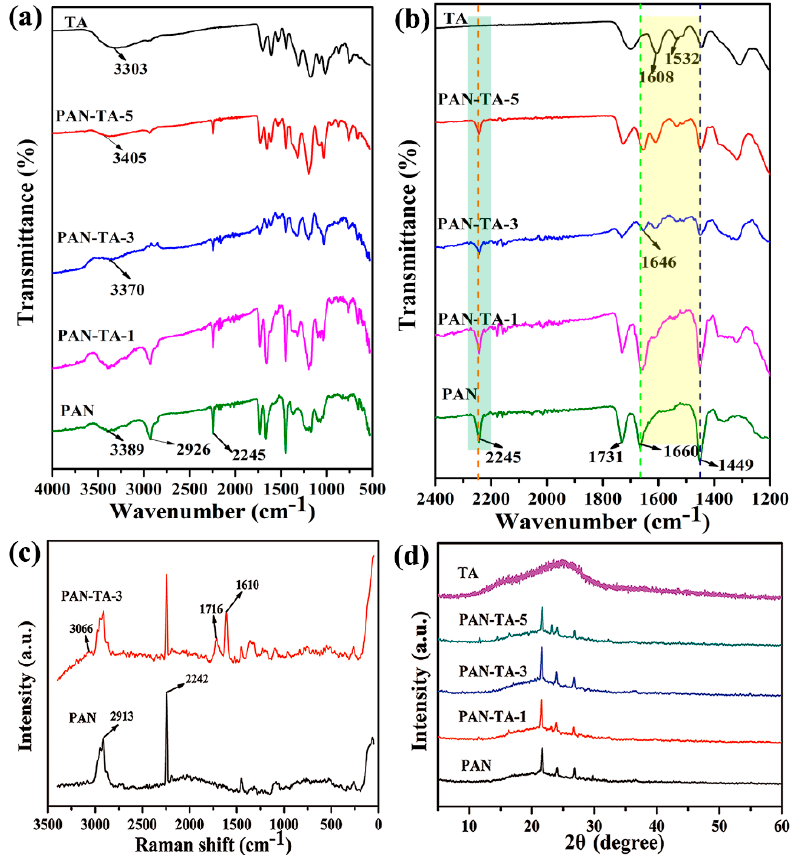
Figure 4. ( a , b ) ATR–IR spectra of PAN and different TA content of PAN–TA nanofibers; ( c ) Raman spectra of PAN and PAN–TA-3 nanofibers; ( d ) XRD patterns of PAN and different TA content of PAN–TA nanofibers.